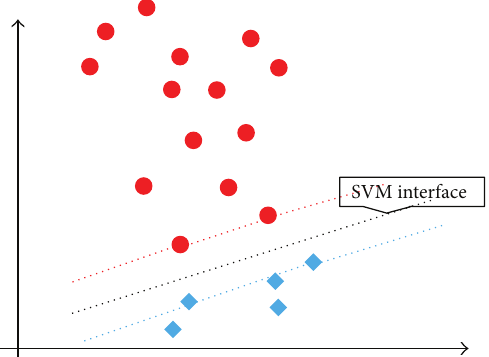
Figure 4: Heterogeneous distribution of the initial instances for C-SVM, Hypothesis 3: when the number of positive instances is larger than the number of negative instances, the positive instances account for a larger area.